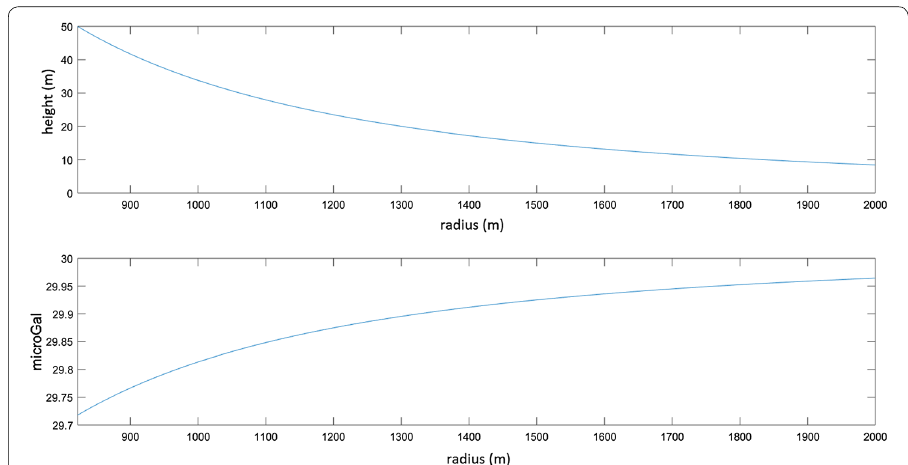
Fig. 13 Height of the cylinder (top) and gravity value at the ground level above the centre of the cylinder (bottom) compared to the radius of the cylinder. A mass of 112.5 MT with a density of 1060 kg m − 3 is injected at 5 km in depth